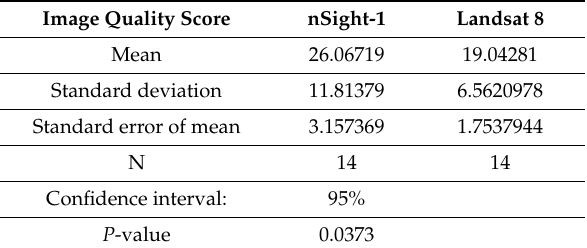
Table 3. Image quality score t -test statistical